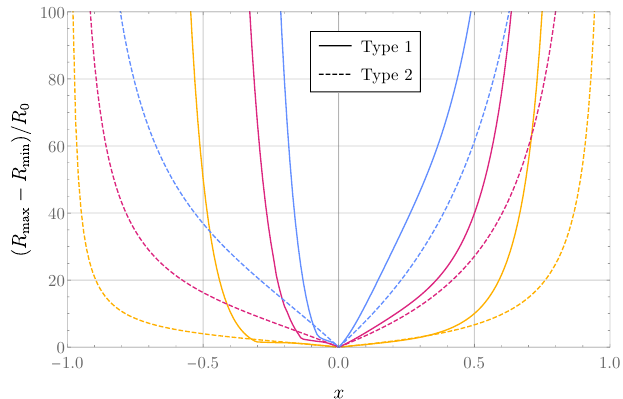
Figure 5 . The difference ( R max − R min ) /R 0 between the maximum and minimum values of the Ricci scalar on the geometries (2.5) and (2.7), normalized by the value on the round sphere R 0 = 2 ; solid orange, magenta, and blue correspond to the l = 2 , 4, and 6 Type 1 geometries, while dashed orange, magenta, and blue correspond to the n = 1 , 2, and 3 Type 2